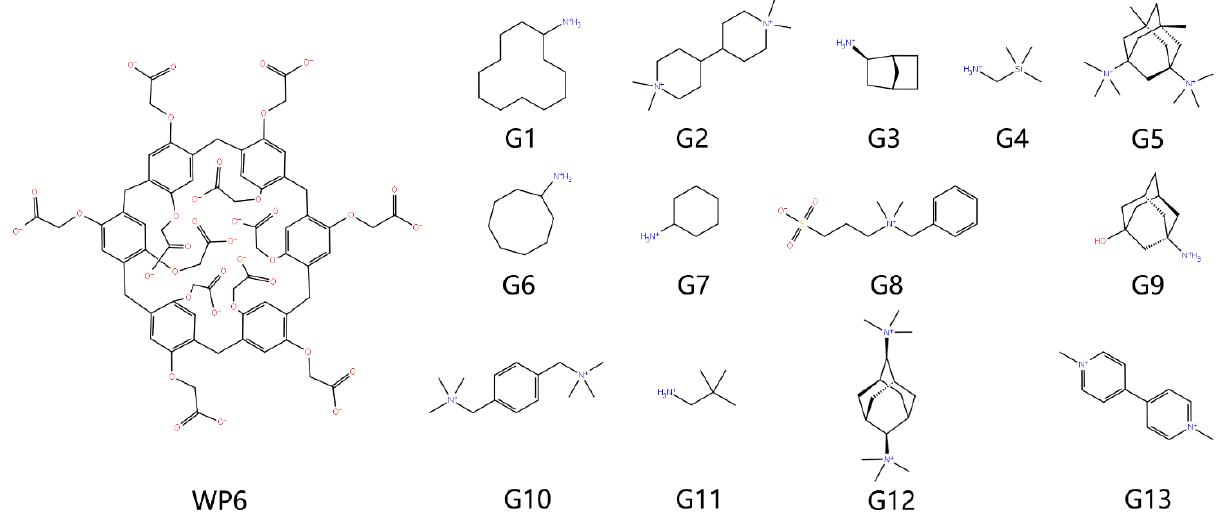
Figure 5. 2D chemical structures of WP6 host–guest systems investigated in the current work. The macrocyclic host WP6 is forming one-to-one coordination complex with all 13 guests (from G1 to G13).